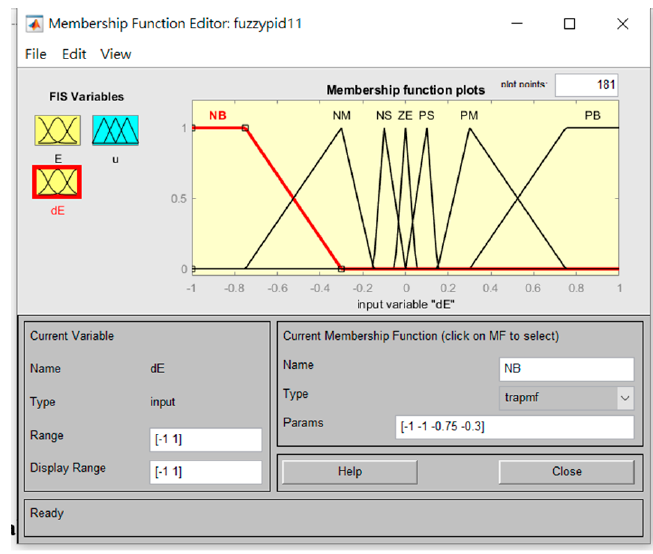
Figure 10. Membership function for input variable “ Δ E”.